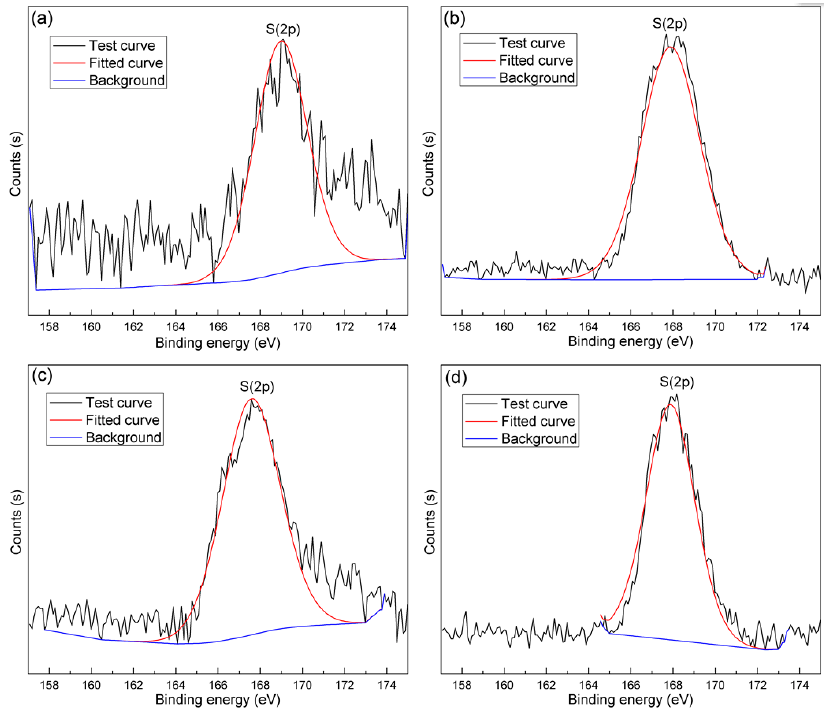
Figure 8. The S(2p) XPS spectra of fluorites treated with sulfonate-based collectors. ( a ) C10; ( b ) C12; ( c ) C12B; and ( d ) C16.